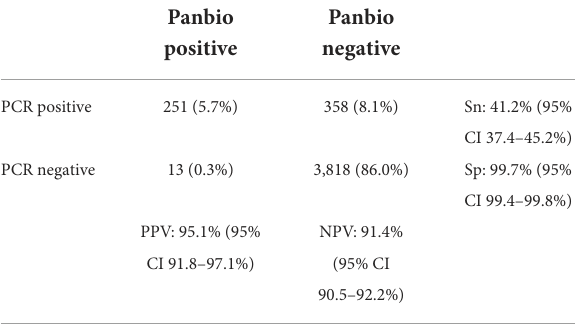
TABLE 4 Analytic performance of Panbio, repetitive tests (696) excluded.